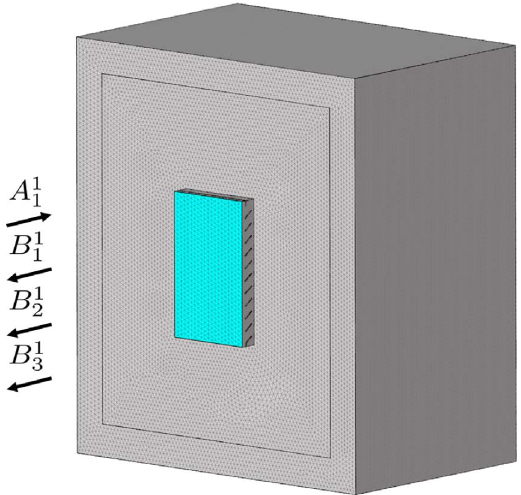
Figure 5. The terminal diffuser modeled as a 1-port system.